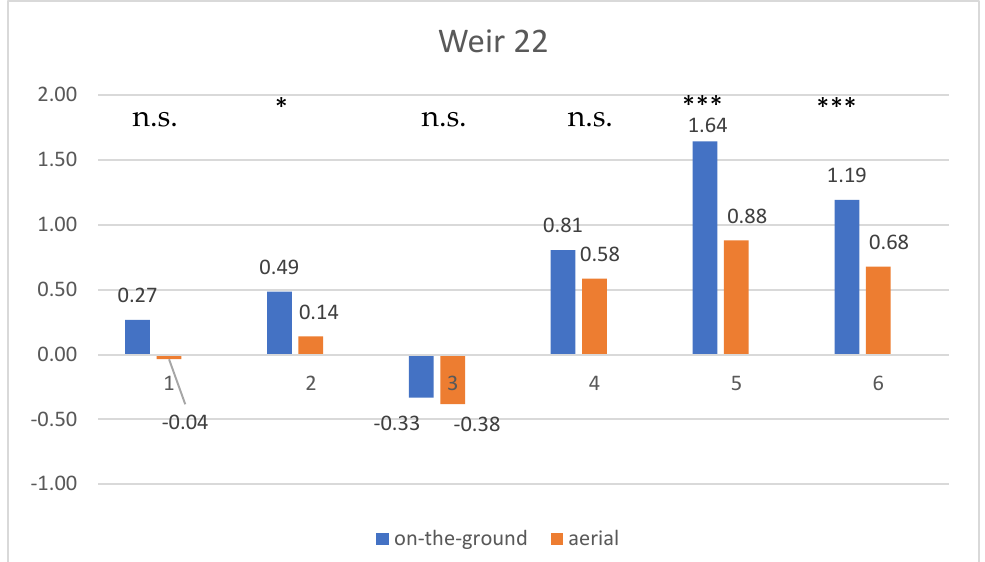
Figure 12. Mean values for preference ratings for pairs of scenarios developed from on-the-ground and aerial perspectives for weir 22 near the Lower Nea power station. Differences between mean values are indicated at the respective significance levels: ***, p ≤ 0,001; **, p ≤ 0,01; and *, p ≤ 0,05. n.s. = not significant.